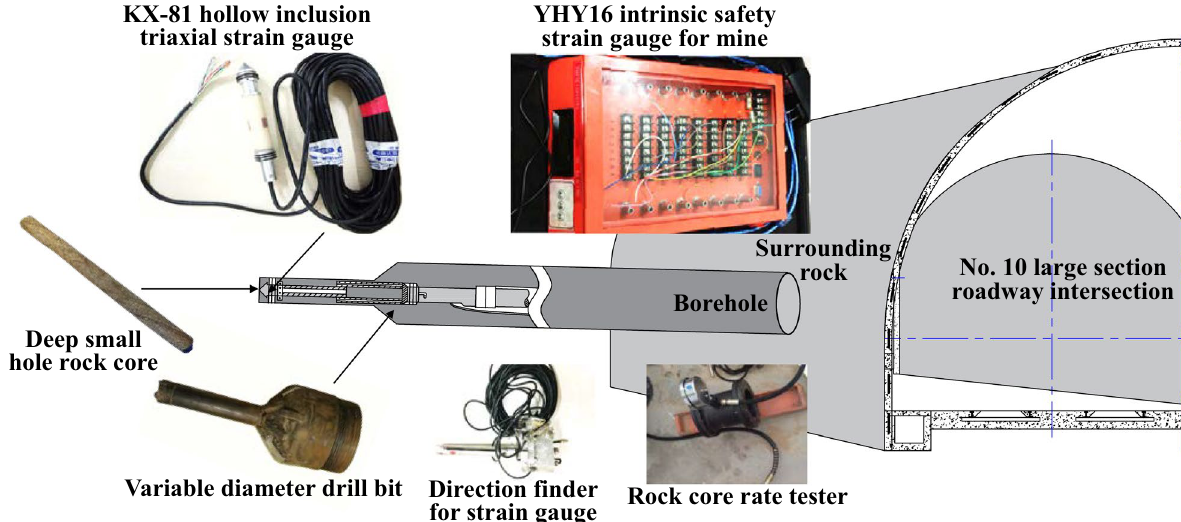
Fig. 6 Schematic of in-situ stress